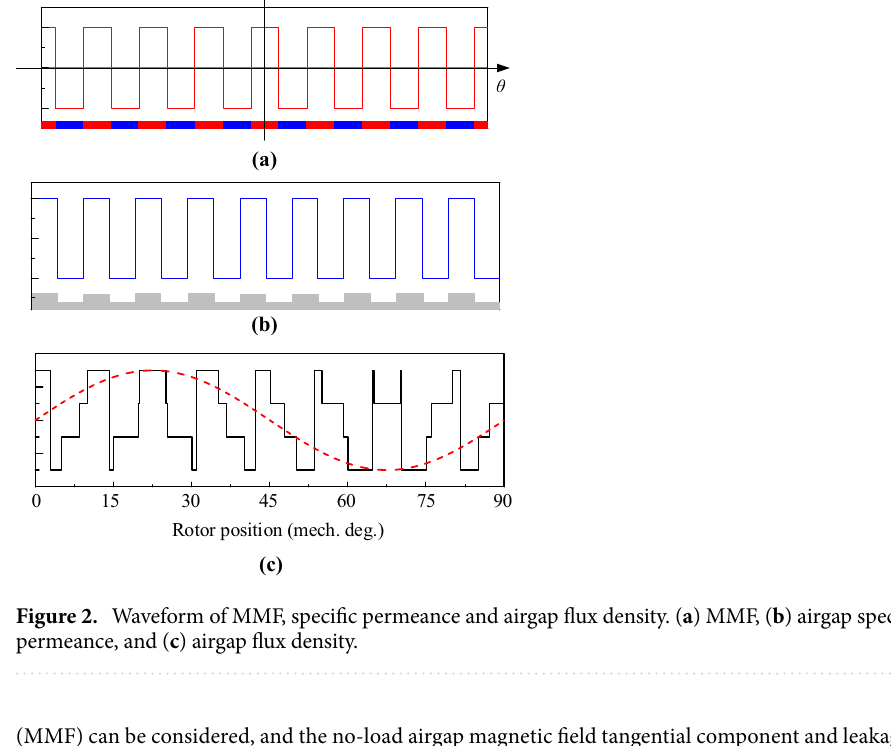
(MMF) can be considered, and the no-load airgap magnetic field tangential component and leakage flux can be ignored. It is also assumed that the permeability of the PM is equal to the permeability of the vacuum. According to the magnetic circuit method, the PM is equivalent to a constant MMF source in series with the PM reluctance, the airgap is represented by the equivalent airgap specific permeance, and the airgap flux density is the product of the two. For the CP-FPGM and BPMEM, each pair of poles on the rotor side is composed of unipolar PMs and adja- cent FMP. Since the pole arc coefficient of the rotor permanent magnet is 0.5, according to Ref. 28 , the magnetomo- tive force generated by the permanent magnet is equal to that generated by the adjacent FMP. The stator PM MMF can be analysed in the same way, but the existence of stator slots makes the actual magnetic resistance higher than that of the PM. This paper focuses on the qualitative analysis of the modulation of the stator FMP to the PMs of the rotor and the modulation of the rotor FMP to the PMs of the stator. Therefore, when the consequent poles of the stator and rotor are equivalent to the alternating PM poles, the PM side is equivalent to a smooth surface. Figure 2 shows the equivalent MMF source of the PM and the equivalent airgap model under the action of the FMP, including 16-pole PMs and 9 FMPs. Figure 2a shows the MMF waveform of alternately arranged bipolar PMs, and its amplitude is related to the shape and material of the PM. Figure 2b is a simplified equivalent cogging structure, and the airgap ratio permeability waveform is obtained from this, and its AC variation characteristic reflects the modulation effect of FMP on the MMF. Figure 2c shows the airgap flux density after the airgap MMF is modulated by the airgap specific permeance. The 16-pole MMF can produce 2 poles after modulation by the airgap specific permeance. The equivalent square wave MMF F r ( θ, t ) of the rotor PM can be obtained after Fourier decomposition: